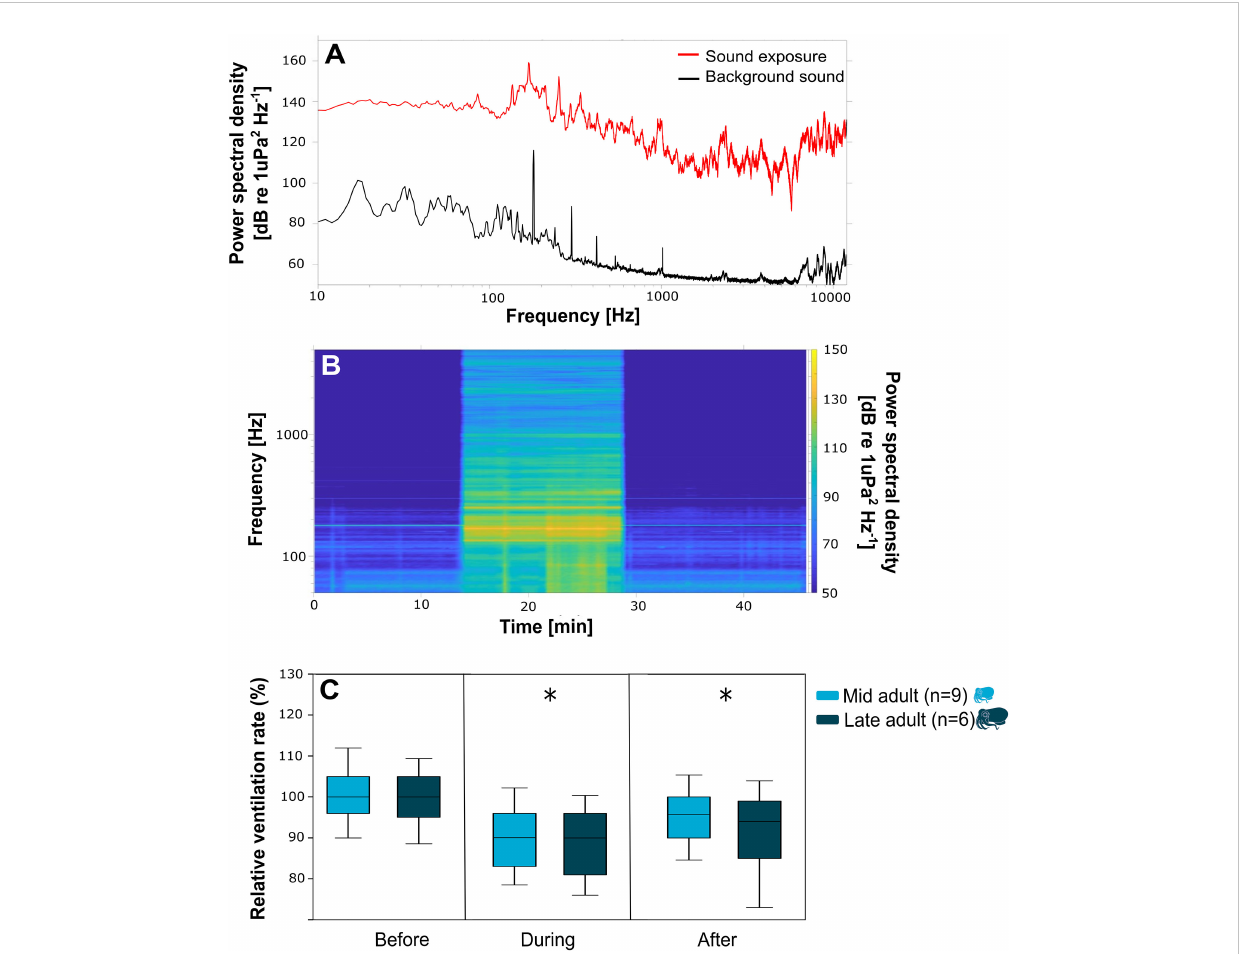
FIGURE 3 (A) Power spectral density (dB re. 1 µPa 2 Hz -1 ) curves versus frequency for the background sound of the experimental tank (black) and sound exposure (red). (B) Spectrogram for the sound exposure trial versus time. (C) Box plots (maximum, 75%, median, 25%, minimum) for relative ventilation rates (breaths min -1 /average pre) of the mid adult (light blue) and late adult (dark blue) versus sound treatment (before; sound exposure, after), asterisk indicates signi fi cant difference to